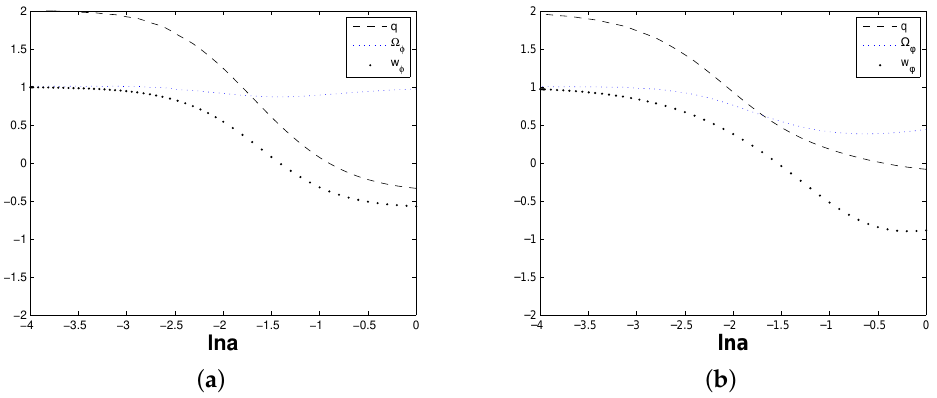
Figure 6. ( a ) The evolutions of Ω φ , w φ and the deceleration parameter q by the initial condition ( x ) = ( − 0.9,1.55 ) around P ( λ , α ) = ( − 0.5,0.01 ) . ( b ) The evolutions of 0 , y 0 4 corresponding to Ω φ , w φ and the deceleration parameter q by the initial condition ( x 0 , y 0 ) = ( − 0.75,1.25 ) around P 6 corresponding to ( λ , α ) = ( − 1, − 0.9 )